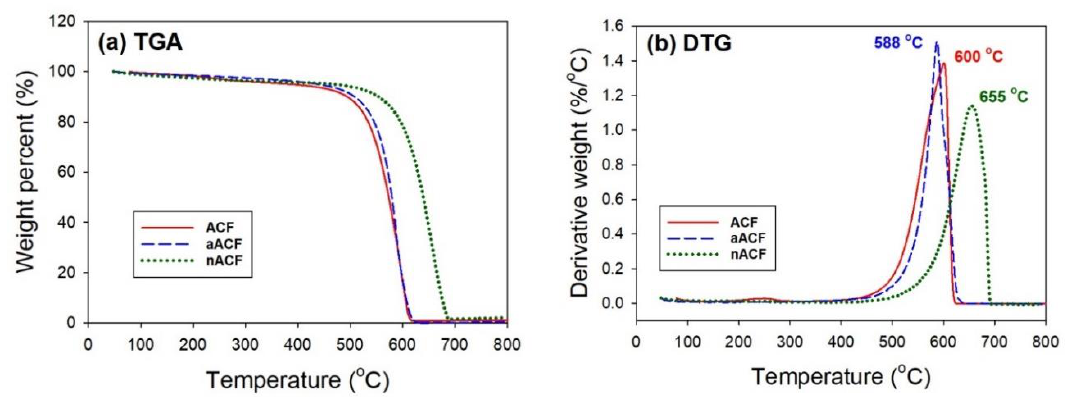
Figure 5. The profiles of ( a ) thermogravimetric analysis (TGA) and ( b ) differential thermogravimetry (DTG) of the samples.